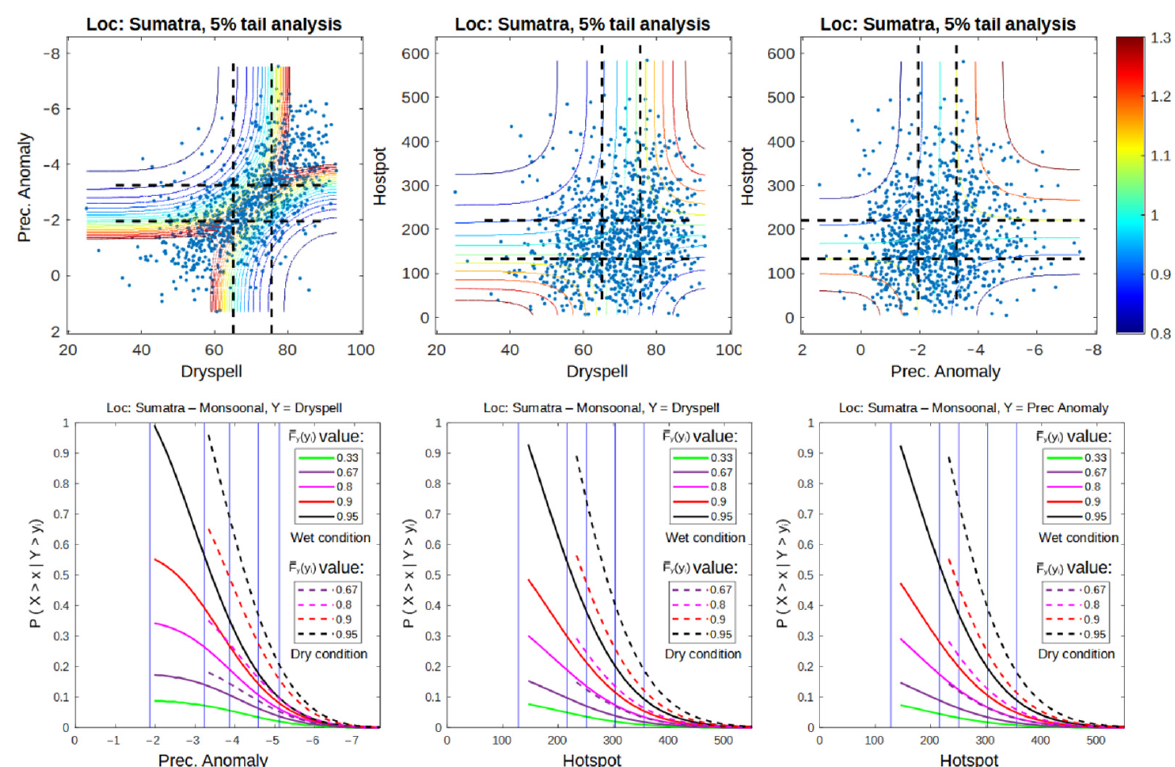
Figure 6. Dependency graph of each variable pair as well as conditional probability of 5% upper right quadrant from all observed data (January 2001–December 2020) on Sumatra with monsoonal-type precipitation.